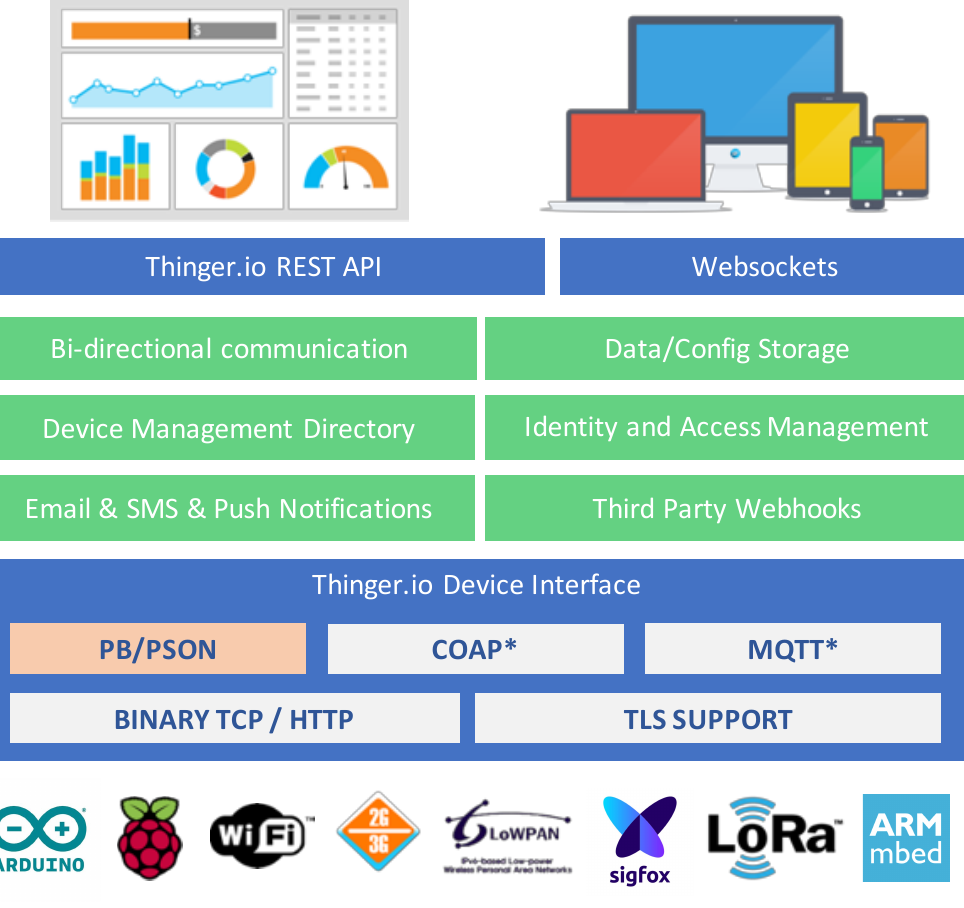
Figure 1. General overview of